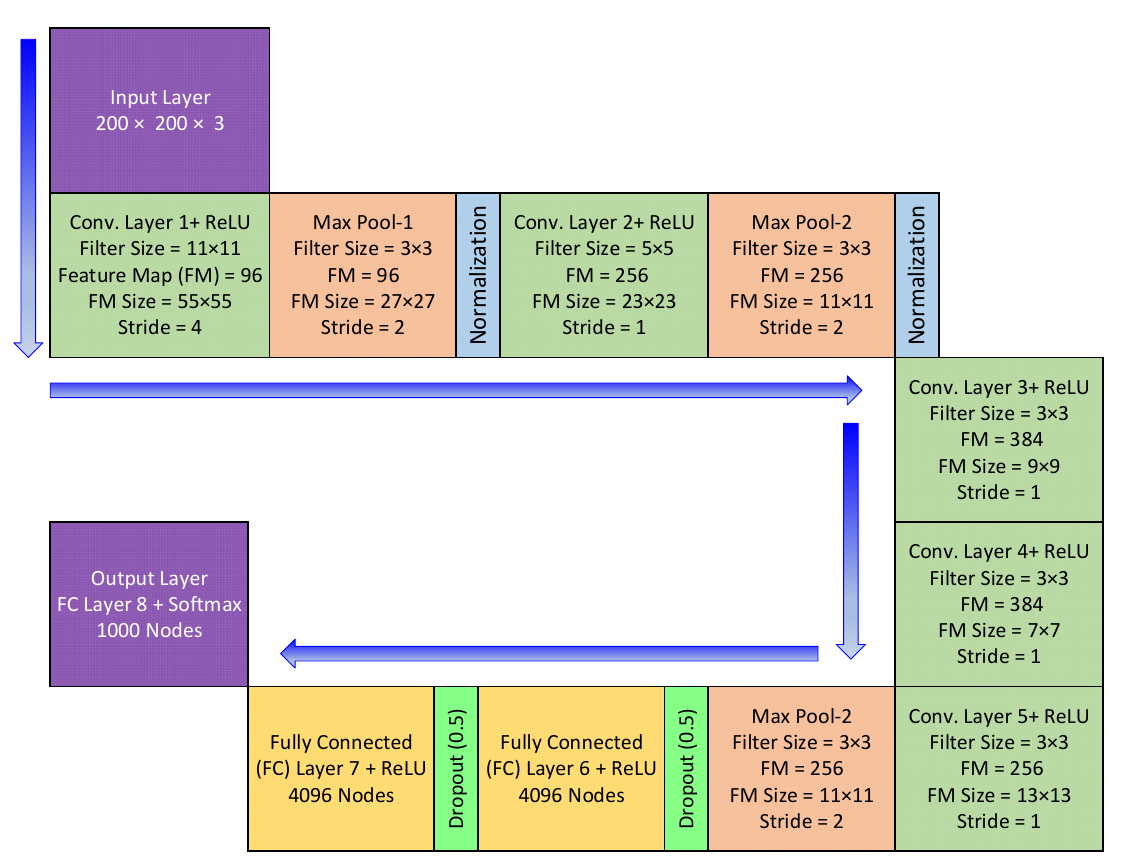
Figure 5. AlexNet basic architecture.